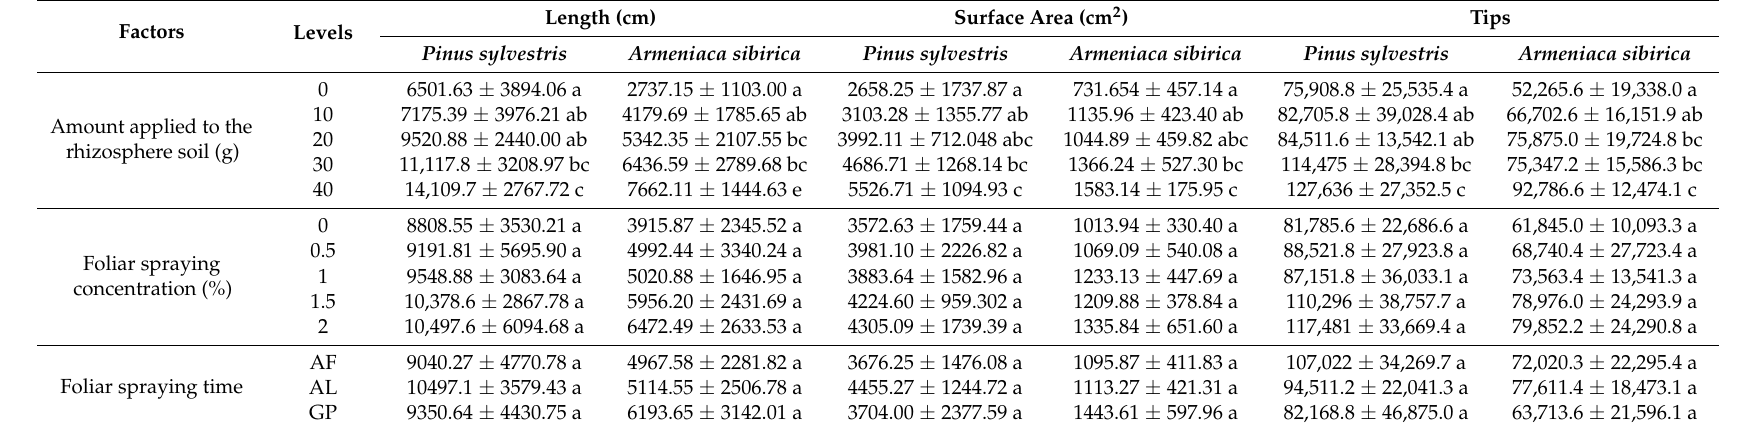
Table 5. Effect of the application of yeast extract on the root parameters of Pinus sylvestris and Armeniaca sibirica . AF, After Forestation; AL, After Leafing; and GP, middle of the growth period. Averages with no common letters have a significant difference at the 0.05